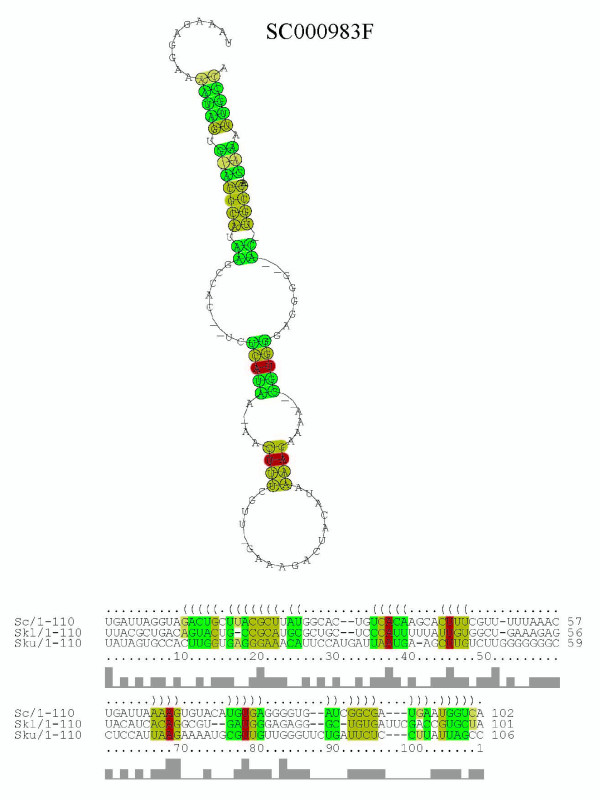
Consensus structure and alignment found in ncRNA candidate SC000983F. This alignment is composed of a S. cerevisiae sequence (chr13/663,965–664,066 bp/-), a S. kluyveri sequence (c2074/4,854–4,954 bp/-), and a S. kudriavzevii sequence (c2037/10,962–11,067 bp/-). The averege pair sequence identity of this alignment is 27%.